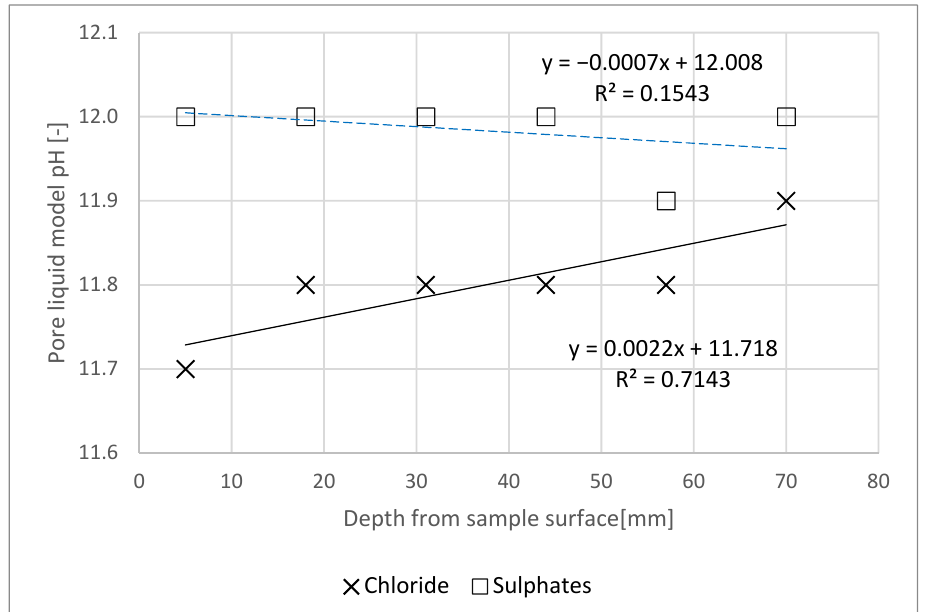
Figure 3. Pore liquid model reaction change profile relative to specimen depth.